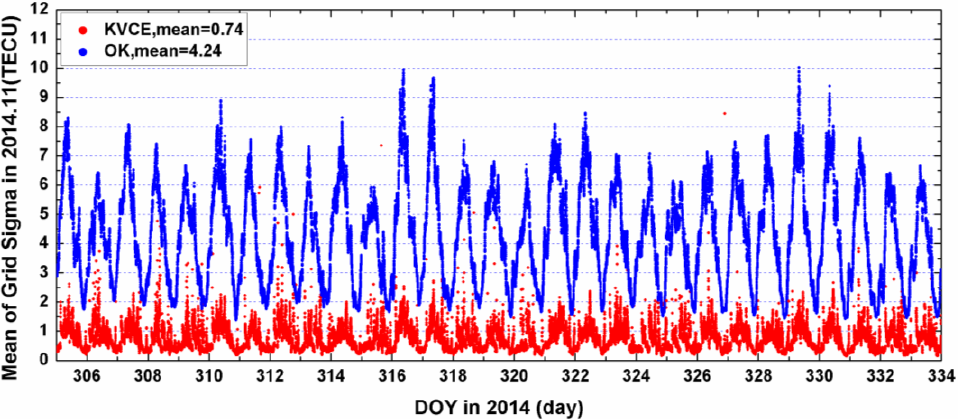
Figure 10. The mean grid sigma of KVCE (red dots) and OK (blue dots) in 2014.11.